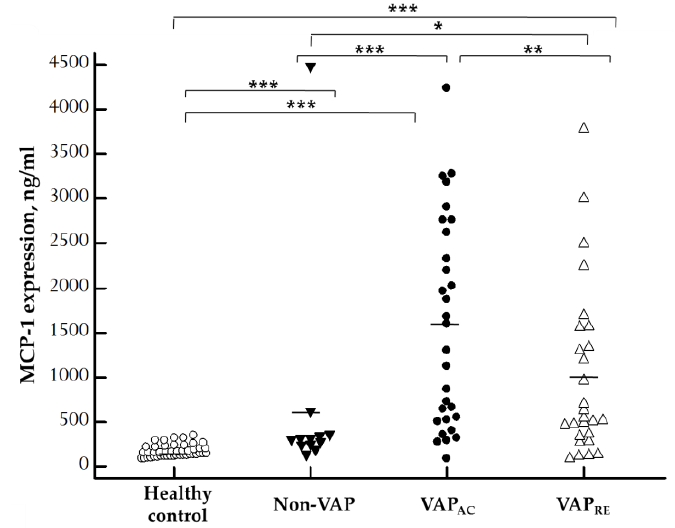
Figure 2. Scatter plots of plasma monocyte chemoattractant protein 1 (MCP-1) levels in 45 healthy control, 12 non-VAP subjects, and 30 patients with VAP who were divided into acute and remission stage according to ELISA results. MCP-1 concentration was significantly higher in the acute stage in VAP patients when compared with non-VAP subjects ( p = 0.0006) and healthy controls ( p < 0.0001), and remarkably decreased after treatment ( p = 0.0082). Moreover, there was also significant difference between non-VAP subjects and healthy controls ( p = 0.0007). Plasma MCP-1 levels were significantly increased in the remission stage in VAP patients when compared with non-VAP subjects ( p = 0.0149) and healthy controls ( p < 0.0001). Each dot represents a single patient. The solid lines mark the mean values. VAP AC , VAP in acute stage, VAP RE , VAP in remission stage. The Kruskal – Wallis test for multiple comparisons was used to determine the differences among the means of various plasma MCP-1, then the Mann – Whitney U test was employed to compare the results between groups, and the paired sample t-test was used for comparisons between acute and remission stage of VAP. * p < 0.05, ** p < 0.01, *** p < 0.001 by statistical analysis.